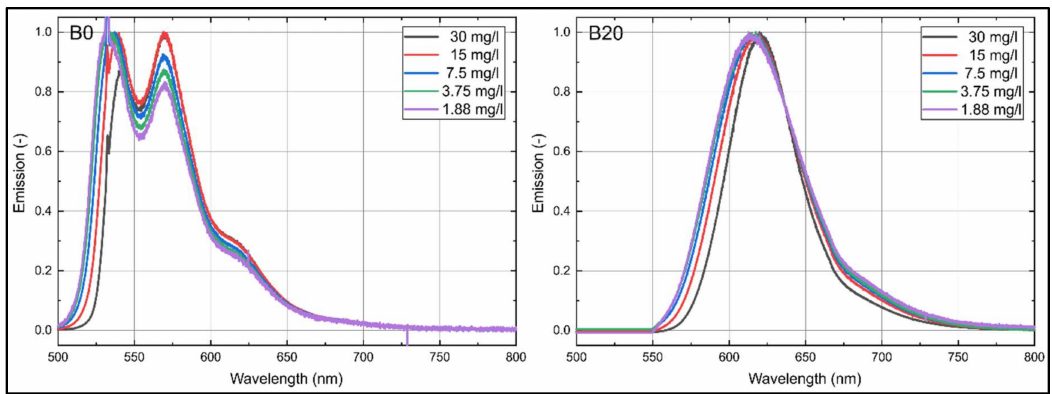
Figure 4. Normalized LIF emission spectra of nile red in B0 and B20 for various dye concentrations; 293